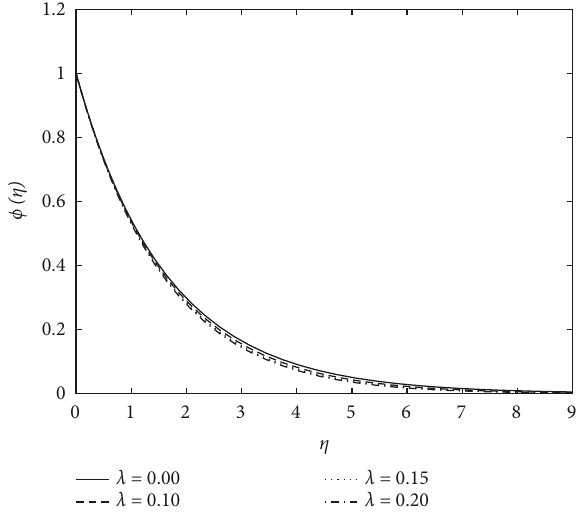
Figure 15: Change in the value of ∅ ( η ) for different values of λ